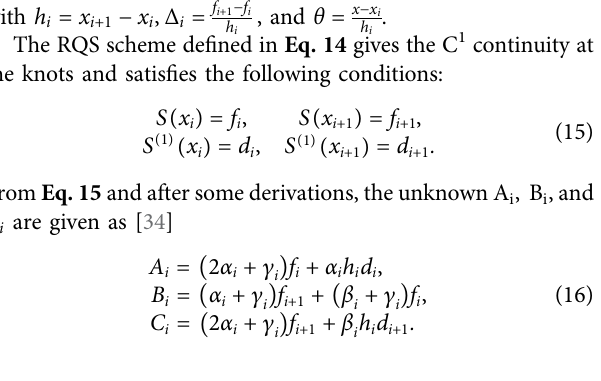
FIGURE 1 | Rational bi-quartic spline de fi ned on a rectangular patch